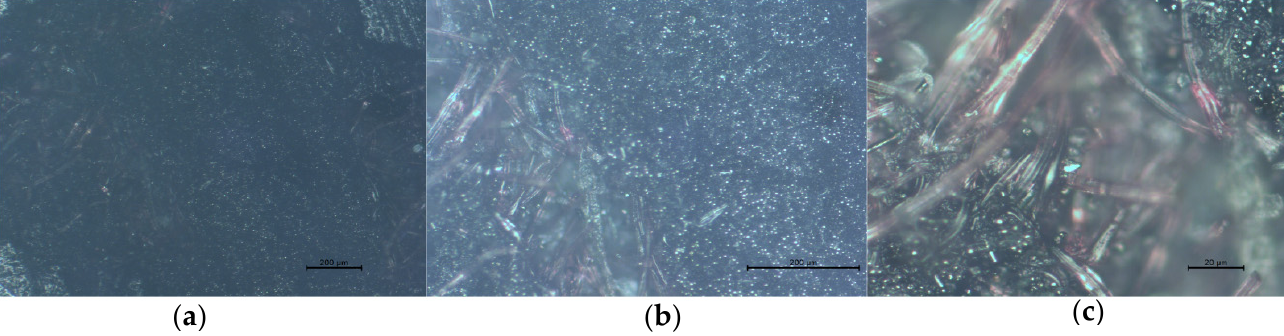
Figure 11. Microscopic view of sample number 3 with different zoom scales. ( a ) 75 × zoom, scale is 200 µ m; ( b ) 150 × zoom, scale is 200 µ m; ( c ) 750 × zoom, scale is 20 µ m.